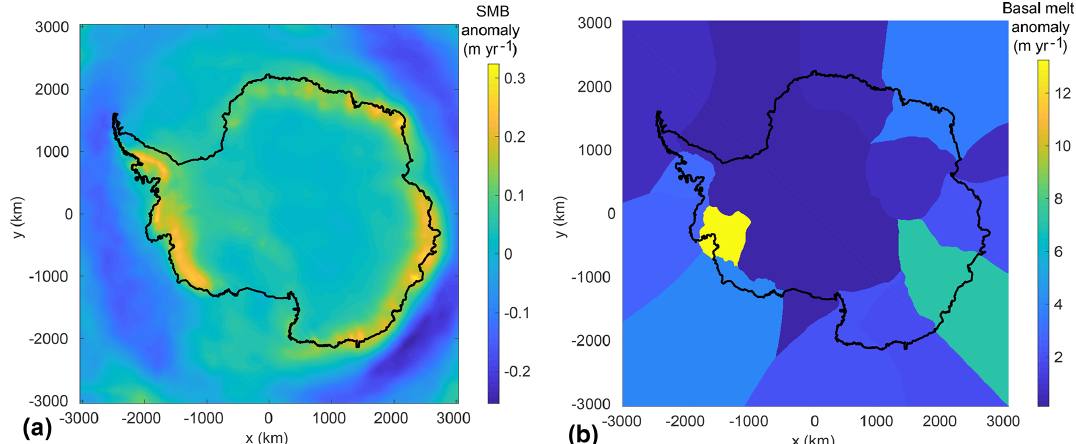
Figure 1. (a) Surface mass balance anomaly (myr − 1 ) for the asmb experiment and (b) basal melt rate anomaly (myr − 1 ) for the abmb experiment. Black contours show the current Antarctic ice